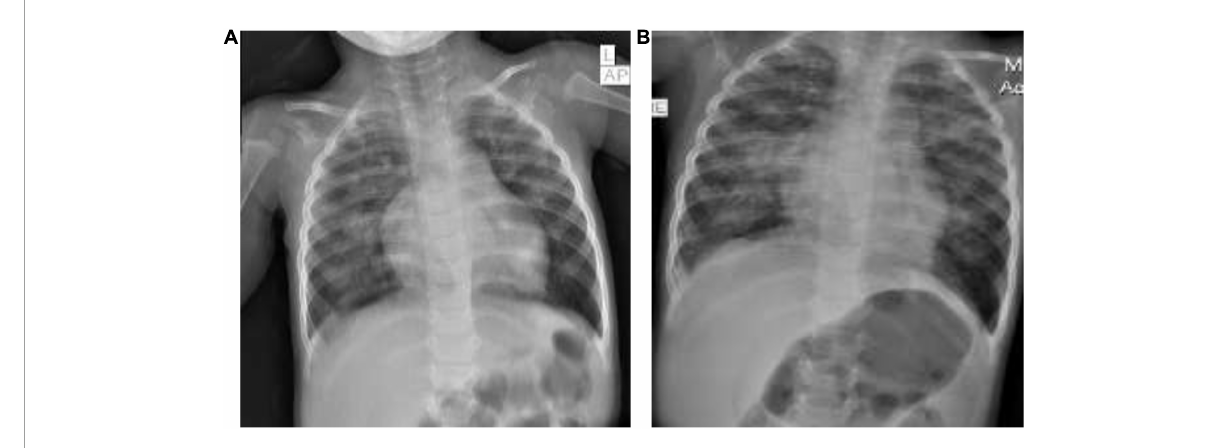
FIGURE2 (A,B) Chest x-rays of the third